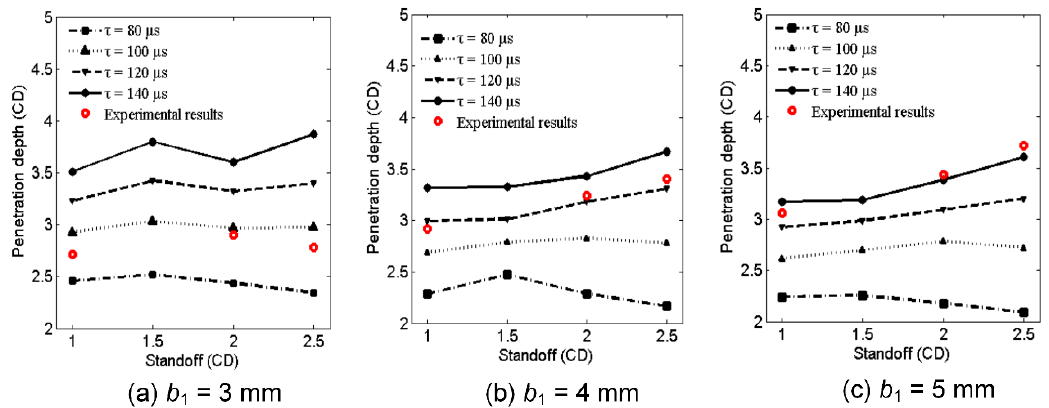
Figure 15. Influence of reactive liner thickness on initiation delay time and penetration depth.